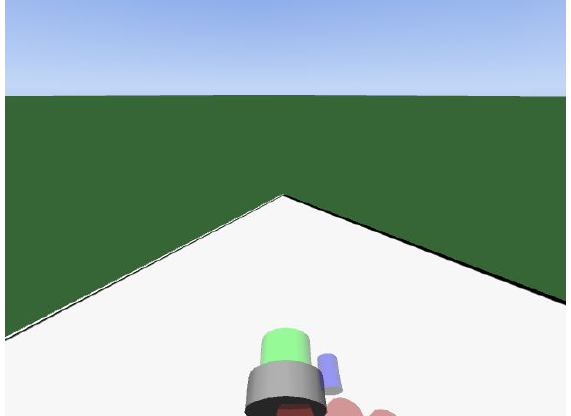
Figure 8. An example of an ambiguous image. In this case, the robot is oriented towards one of the corners of the field. Since no fiducial marker is visible, it is not possible to determine the pose of the robot from the image